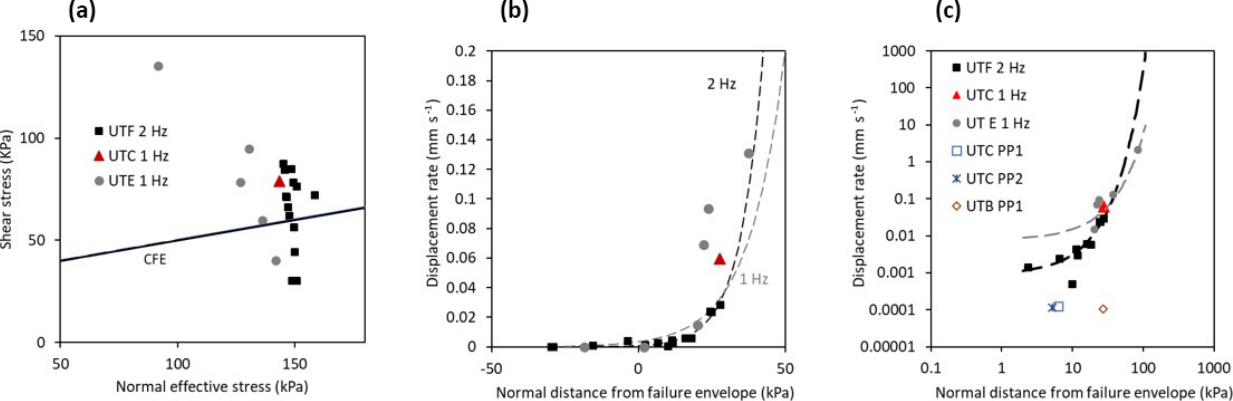
Figure 10. Results of dynamic shear experiments undertaken at 1 and 2Hz. (a) Average normal effective stress against maximum shear stress in relation to the conventional failure envelope (CFE). (b) Displacement rate against normal distance from the failure envelope. (c) Displacement rate against normal distance from the failure envelope in log scale including pore pressure experiments.